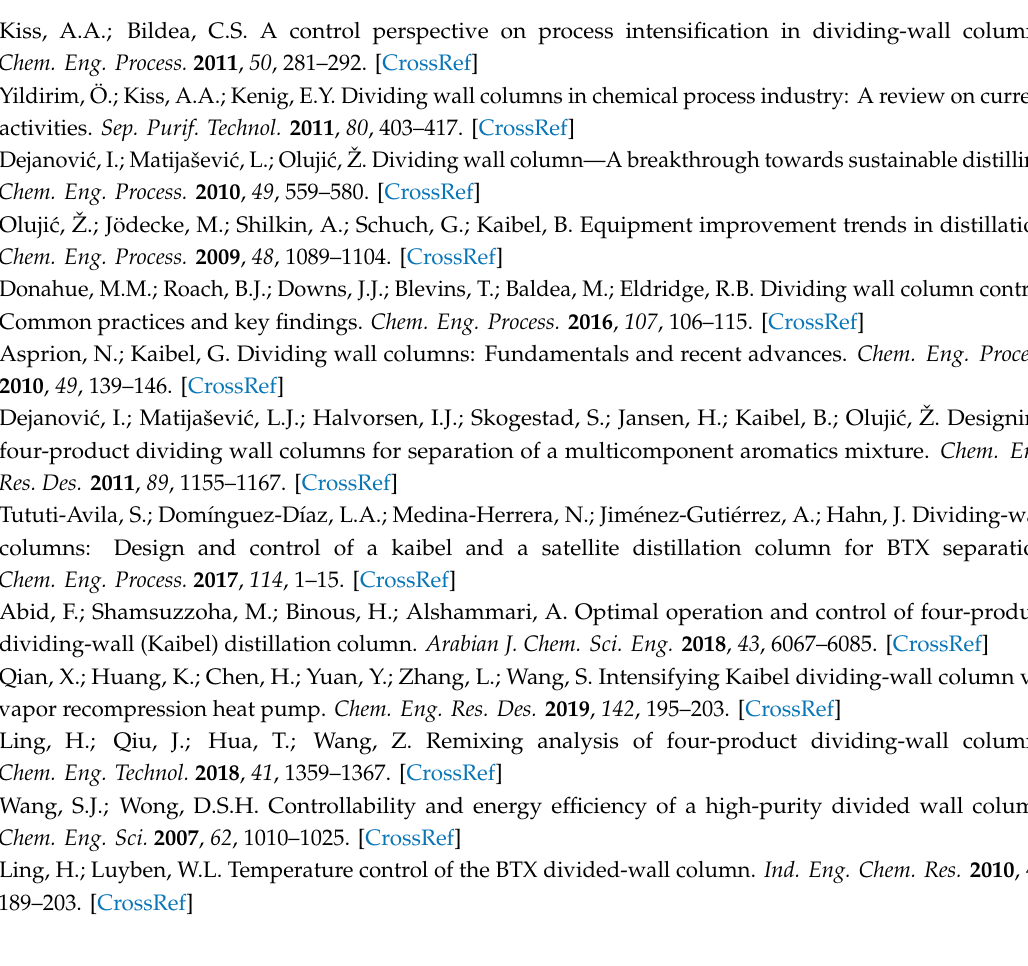
Figure S1: A simple sequential search algorithm for the synthesis and design of the Kaibel distillation column, Figures S2–S23: Dynamic responses of the upper sidestream control loop of the MEPB Kaibel distillation column controlled, respectively, under the CS R / QR , CS R / B , CS D / QR , and CS D / B structures after facing step changes in feed compositions and feed flow rate. Table S1: Column dimensions of the MEPB Kaibel distillation